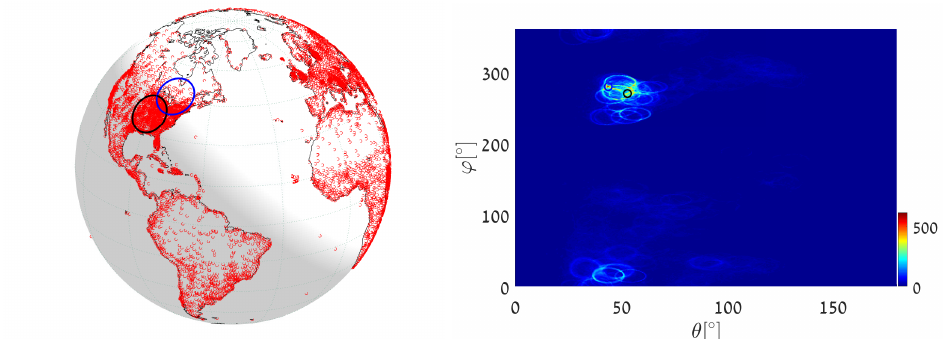
Figure 26. Executing Algorithm 3 with r = 0.125 on the city database. ( Left ) The blue circle passes through the maximum number (616) of cities (red dots). The black circle, passing through 386 cities, corresponds to the second maximum, following the unvoting process. ( Right ) Heat plot of the accumulator array M , showing the parameters of the two